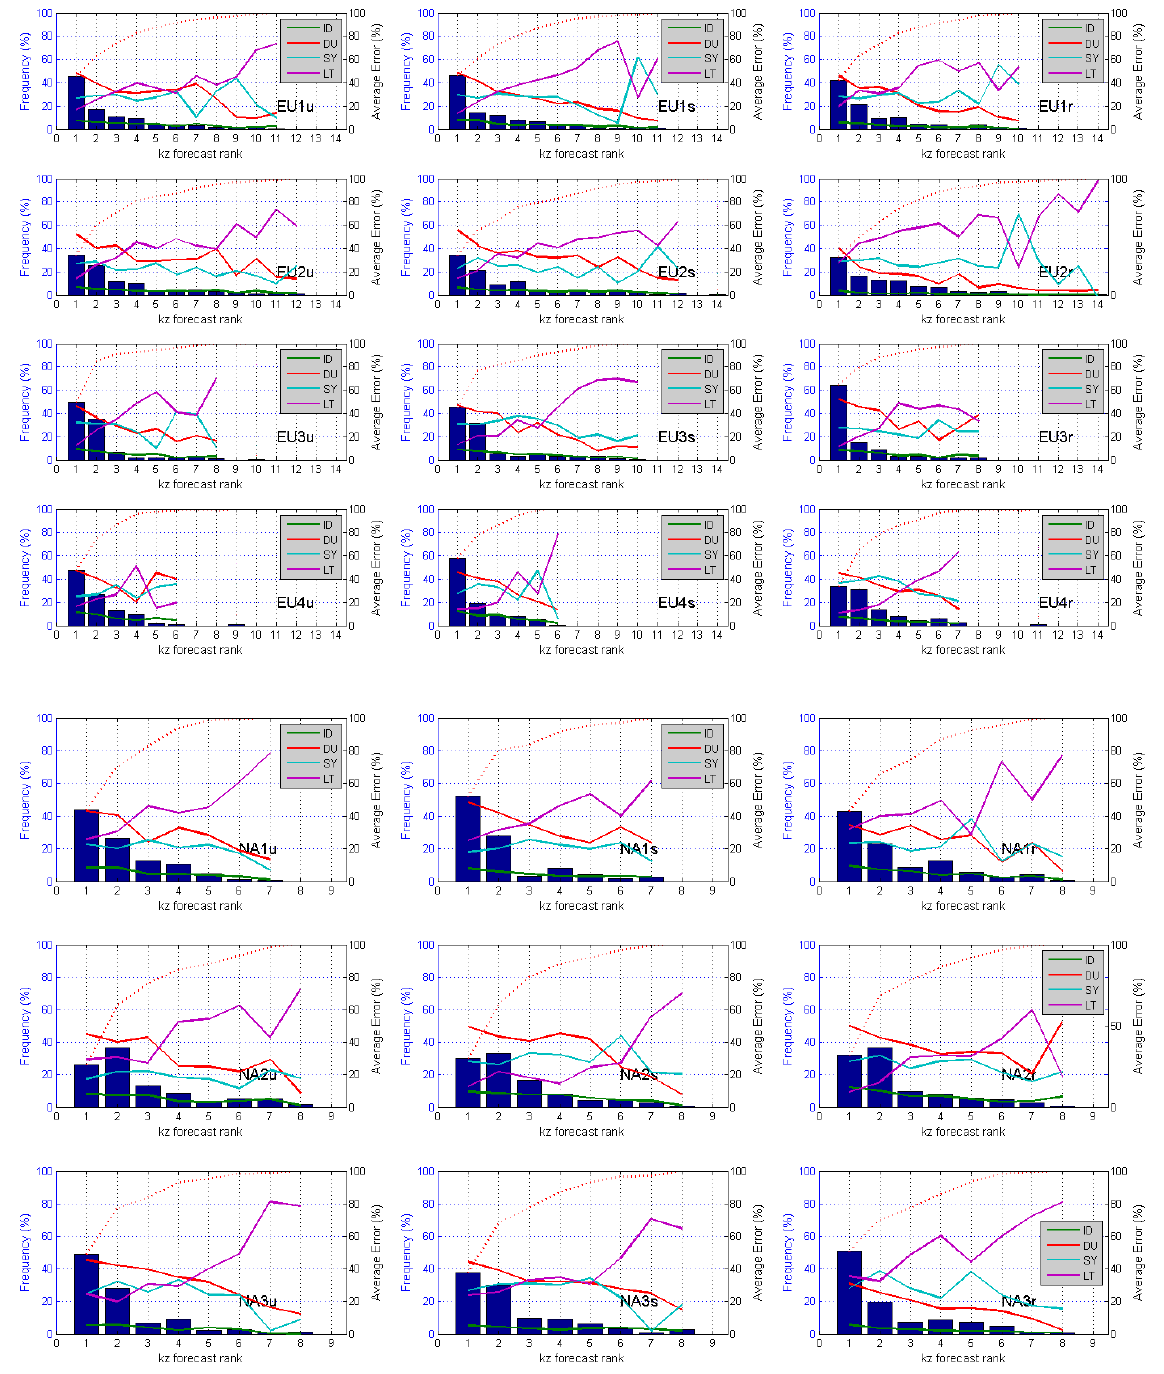
Fig. 13. Ranking frequency of the kz model together with the average spectral error at all rankings. Top is EU, bottom is